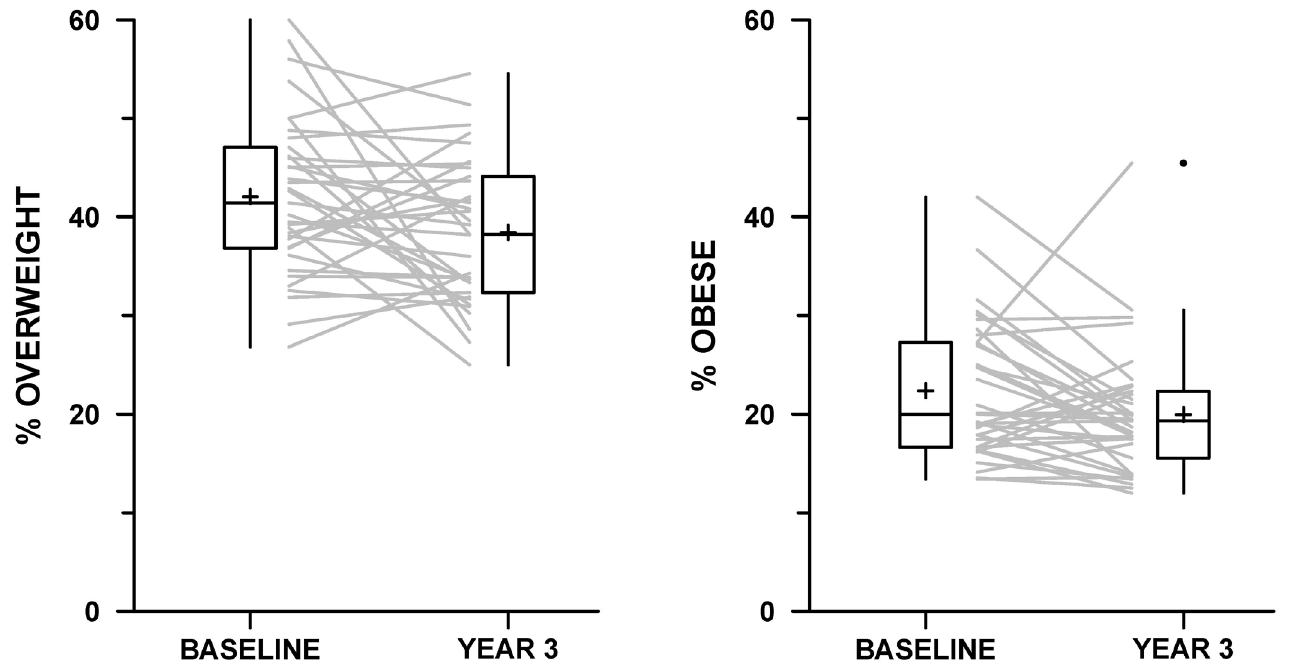
Fig 1. Change in school-level percent overweight and obese and percent obese from baseline to follow-up, Massachusetts Healthy Choices (n = 35).